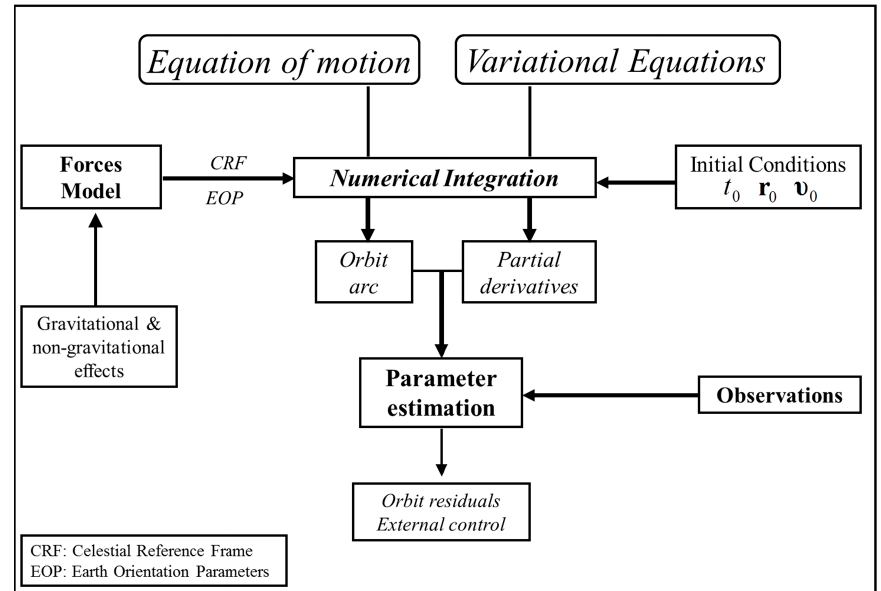
Figure 1. Principal objectives of satellite orbit determination [31]. The current orbit analysis applies